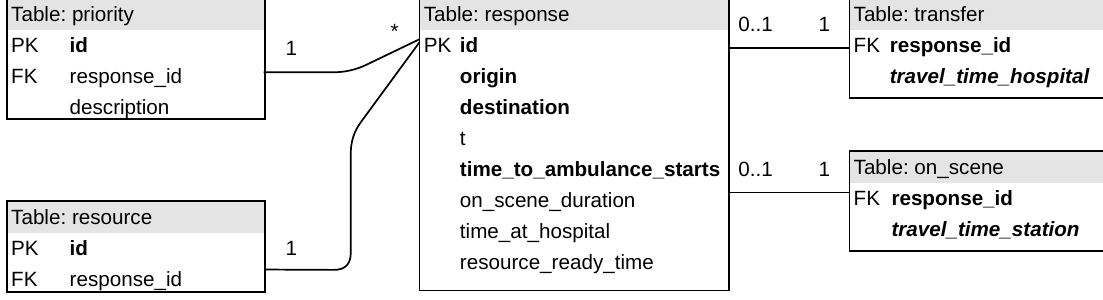
Figure A4. A UML diagram of the relational design of the simulation dataset. Indexed attributes are in bold whereas clustered attributes are in italics.